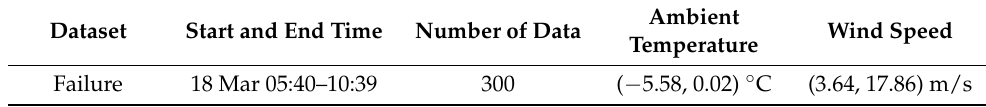
Table 7. Datasets of main bearing offset